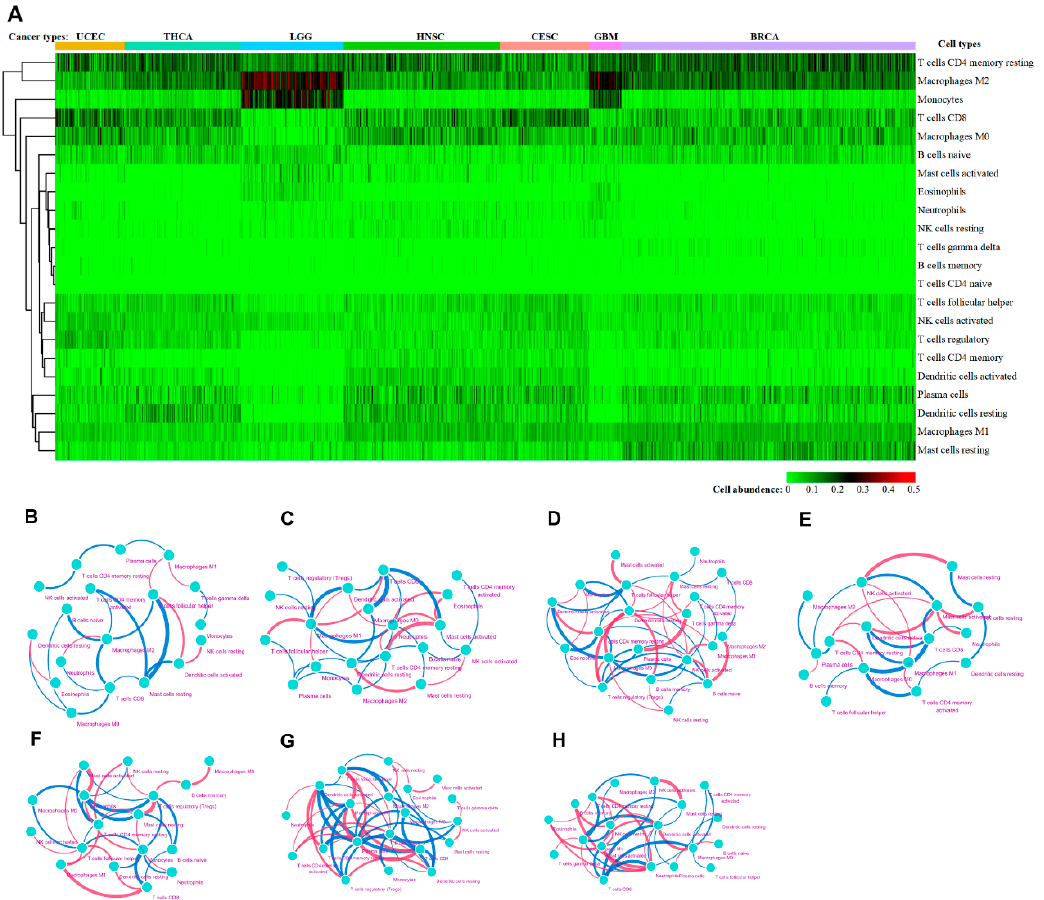
Figure 3. Composition of immune cells and their correlations across seven cancer types. ( A ) Heatmap was used to exhibit the di ff erent immune cells abundance across seven cancer types. Each column represents a patient sample, and each row represents an immune cell. The color represents the abundance of the di ff erent immune cells. The color bars above the picture represent di ff erent types of cancer, they are UCEC, THCA, LGG, HNSC, CESC, GBM, BRCA, respectively. ( B – H ) Correlation of 22 immune cells in TME across seven cancer types, among which the line thicknesses and color represented correlation, blue represented negative correlation, red represented positive correlation, and the thicker the line, the larger the correlation coe ffi cient. Each dot in the figure represents an immune cell. In these figures, only the cells with high correlation coe ffi cients were